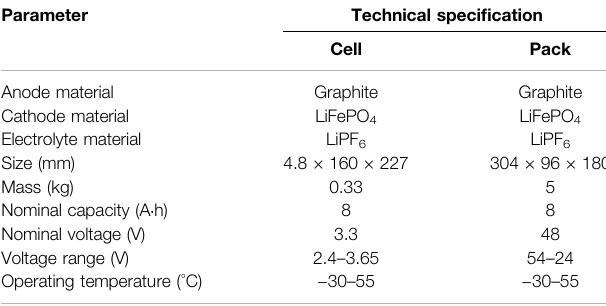
TABLE 1 | Main technical parameters of the lithium-ion battery and 48 V battery pack.